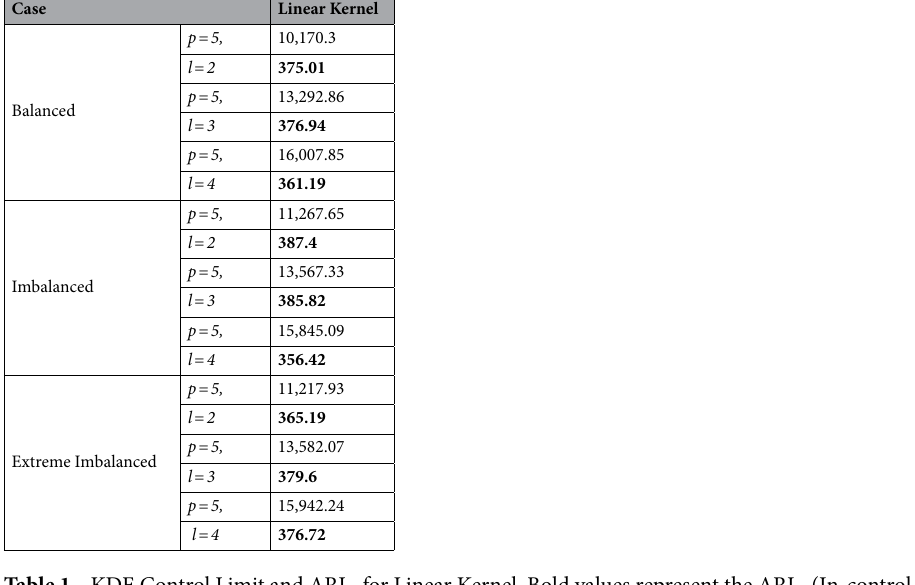
Table 1. KDE Control Limit and ARL 0 for Linear Kernel. Bold values represent the ARL 0 (In-control ARL).